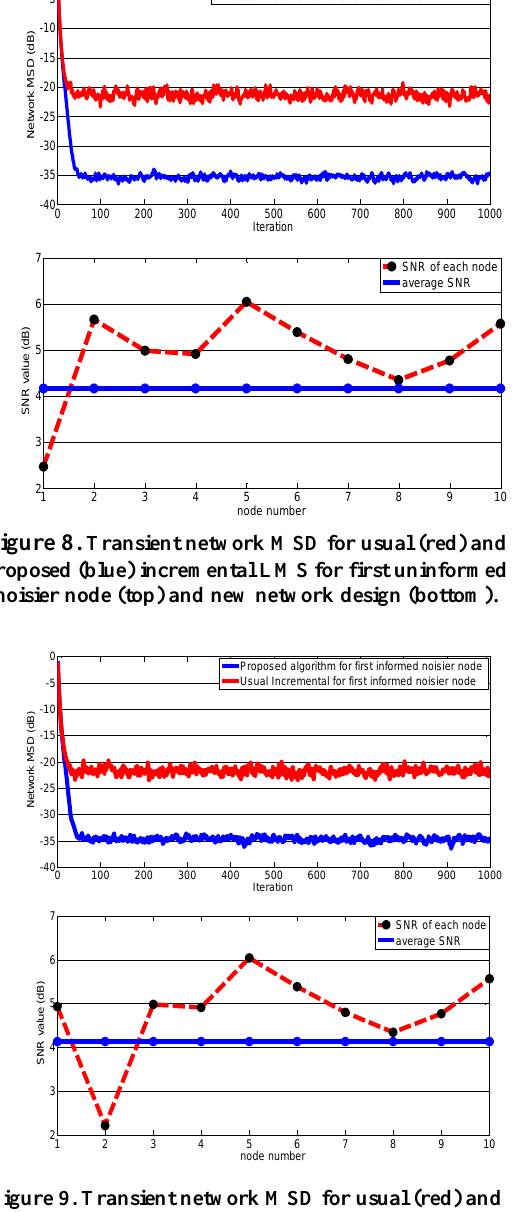
Figure 9. Transient network MSD for usual (red) and proposed (blue) incremental LMS for first informed noisier node (top) and new network design (bottom).